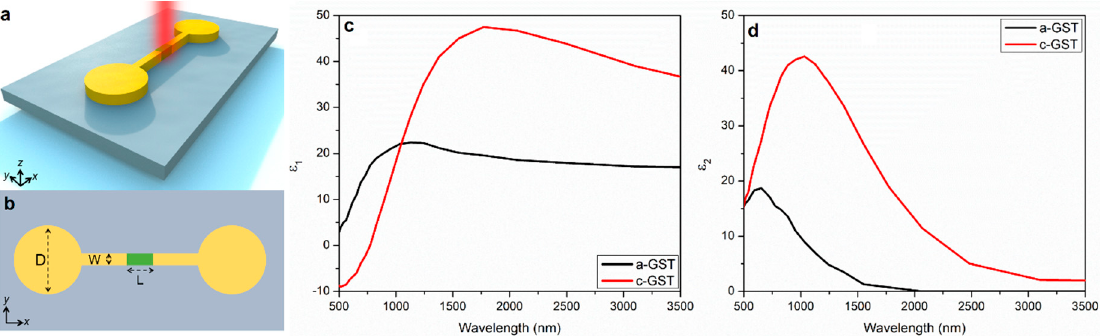
ε 1 and ε 2 values for both